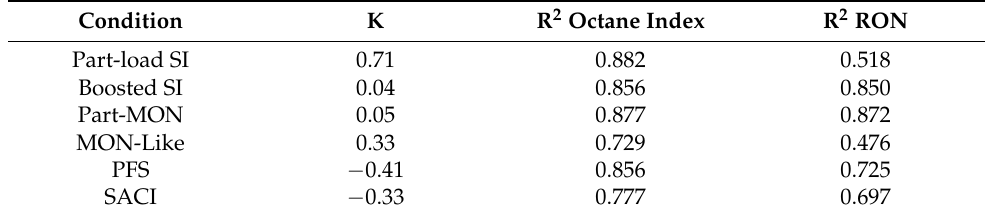
Table 4. K-values and R 2 correlation